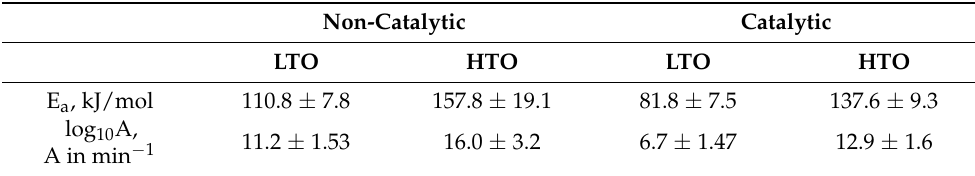
Table 3. Kinetic parameters of peat oxidation processes.